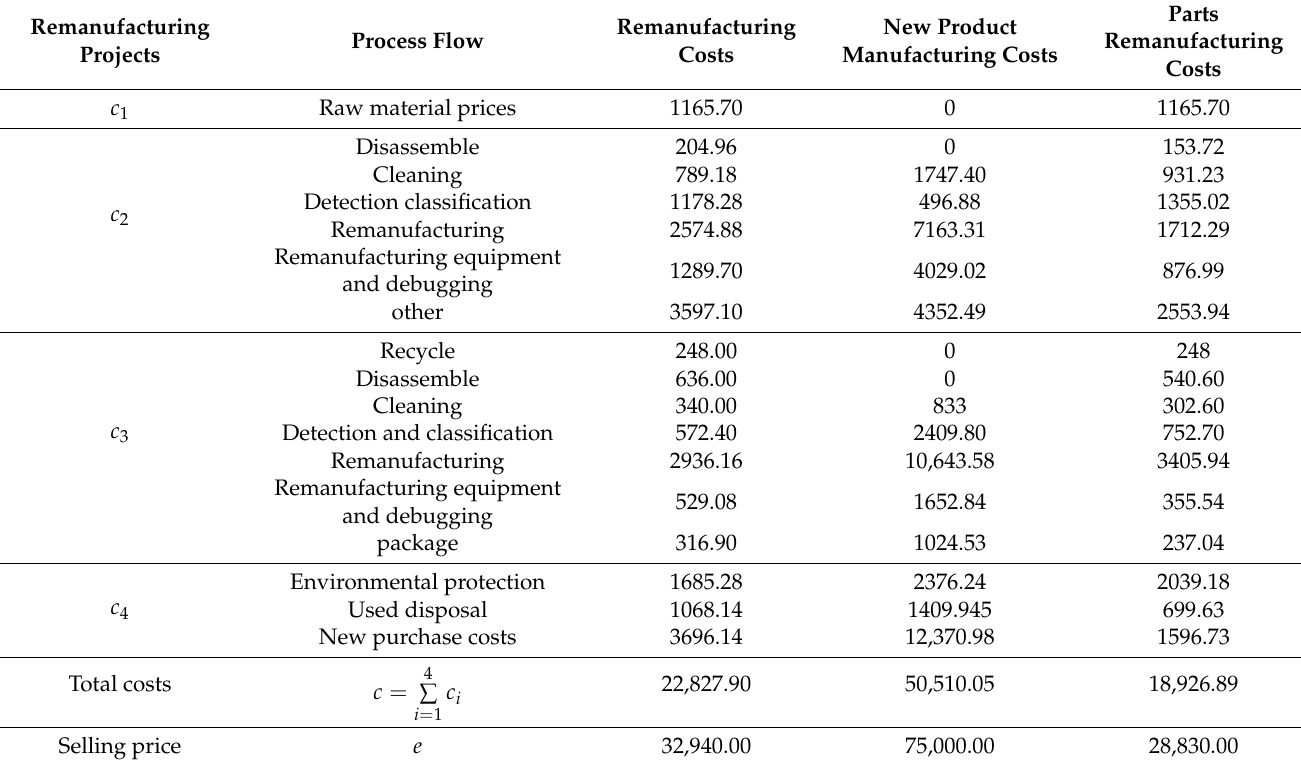
Table 6. List of remanufacturing costs and selling price of recycled parts (Unit: